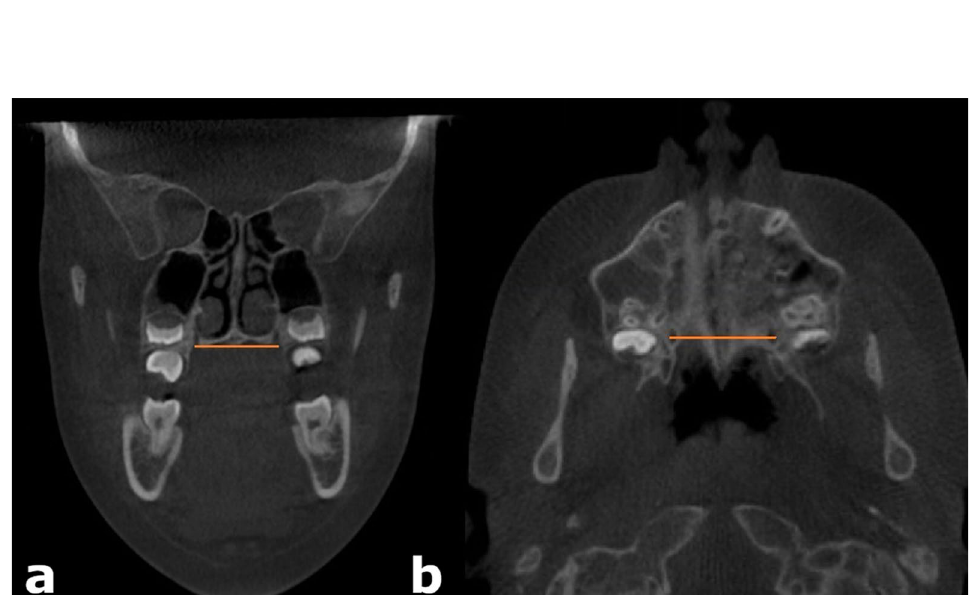
Figure 2. Measurement of the linear distance between the lateral margins of the greater palatine foramina (GPFd). ( a ) Coronal view, ( b ) Axial